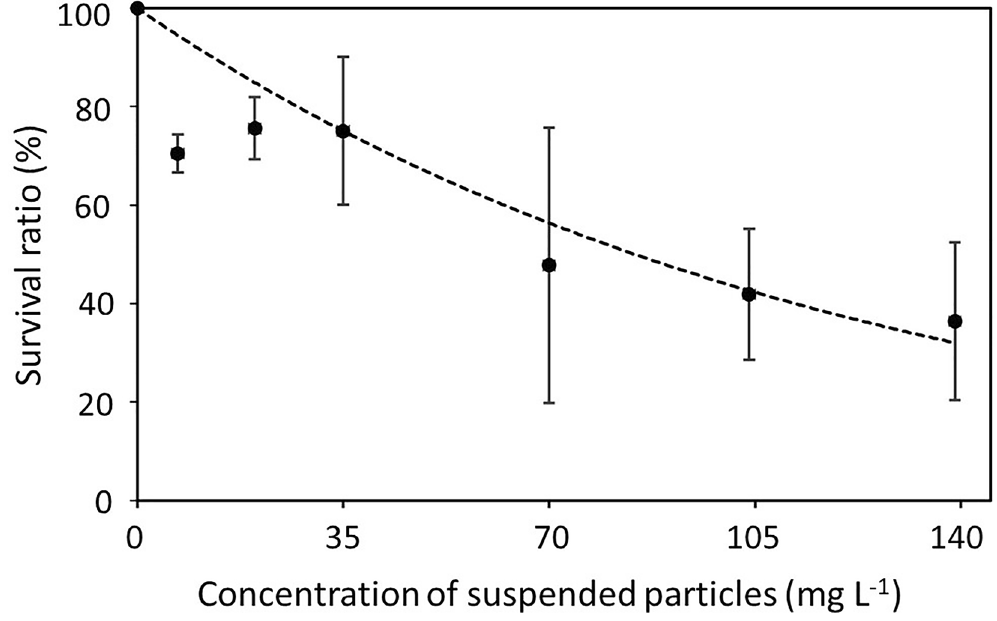
Figure 3. Relationship between suspended particle concentration and relative survival ratio of elaphocaris larvae after 8 days of exposure ( p < 0.05).